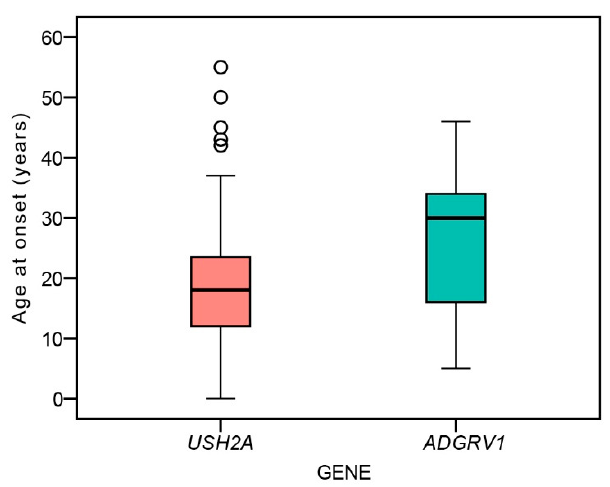
Figure 1. Boxplot chart showing the ages at onset of nyctalopia in the two patient groups. Horizontal lines represent the median values, boxes represent half of the data for each group/mutation, and whiskers represent the remaining data except in the case of the outliers (circles). Red color represents USH2A patients and green color represents ADGRV1